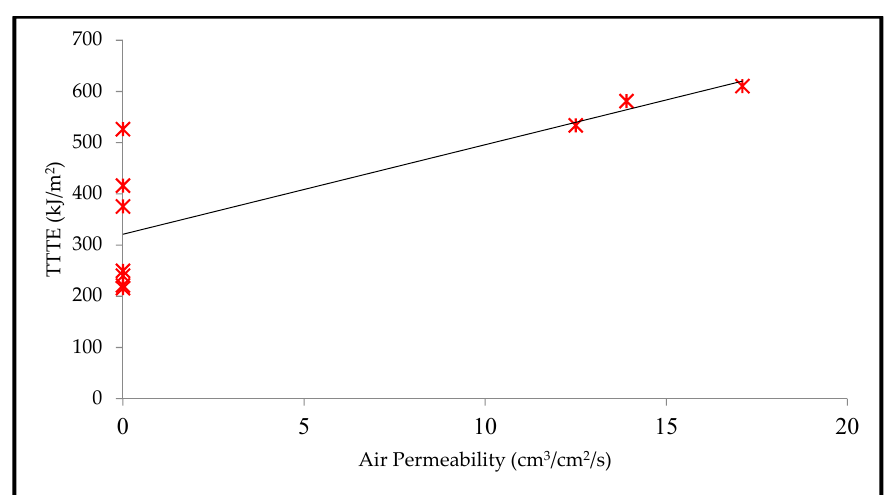
Figure 9. Relationship plot of air permeability and TTTE.